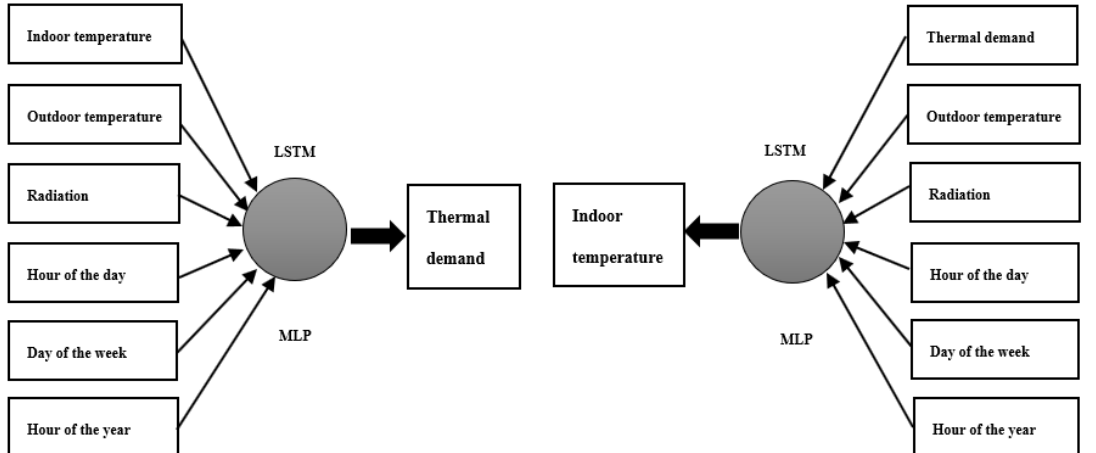
Figure 3. The variables used as input into the models to predict the thermal demand of the building (left) and the indoor temperatures of the building (right).